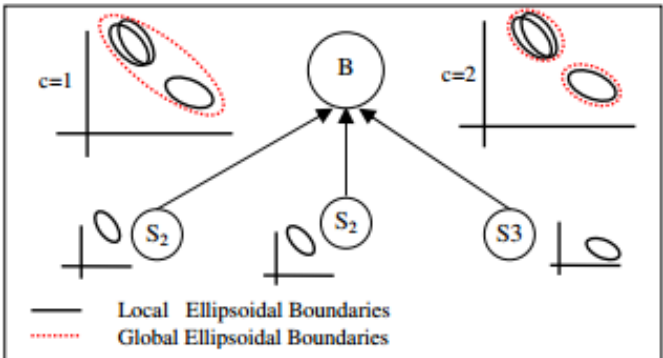
Figure 6. Clustering ellipsoids for anomaly detection in WSNs